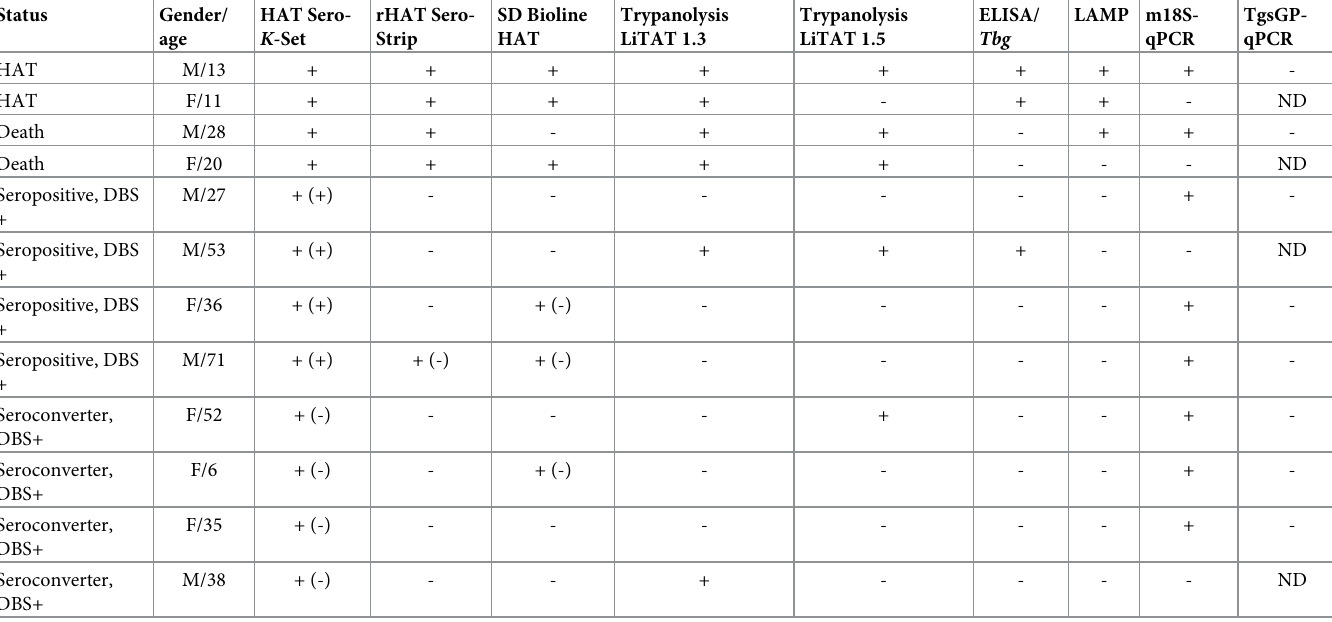
Table 2. Detailed test results and outcome of 12 RDT positive, laboratory test positive study